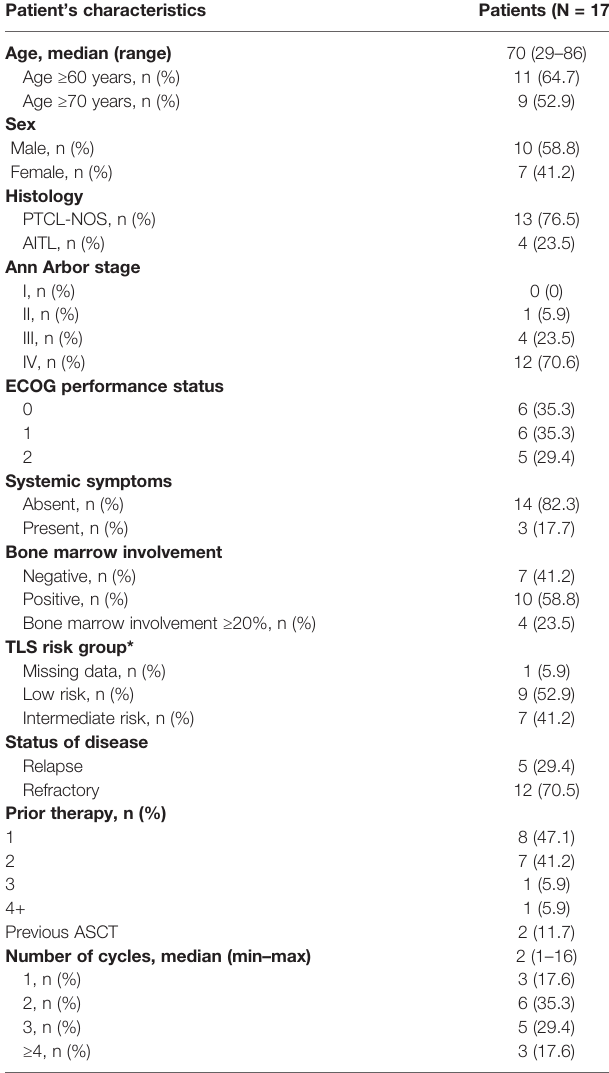
TABLE 1 | Patient ’ s characteristics at the time of